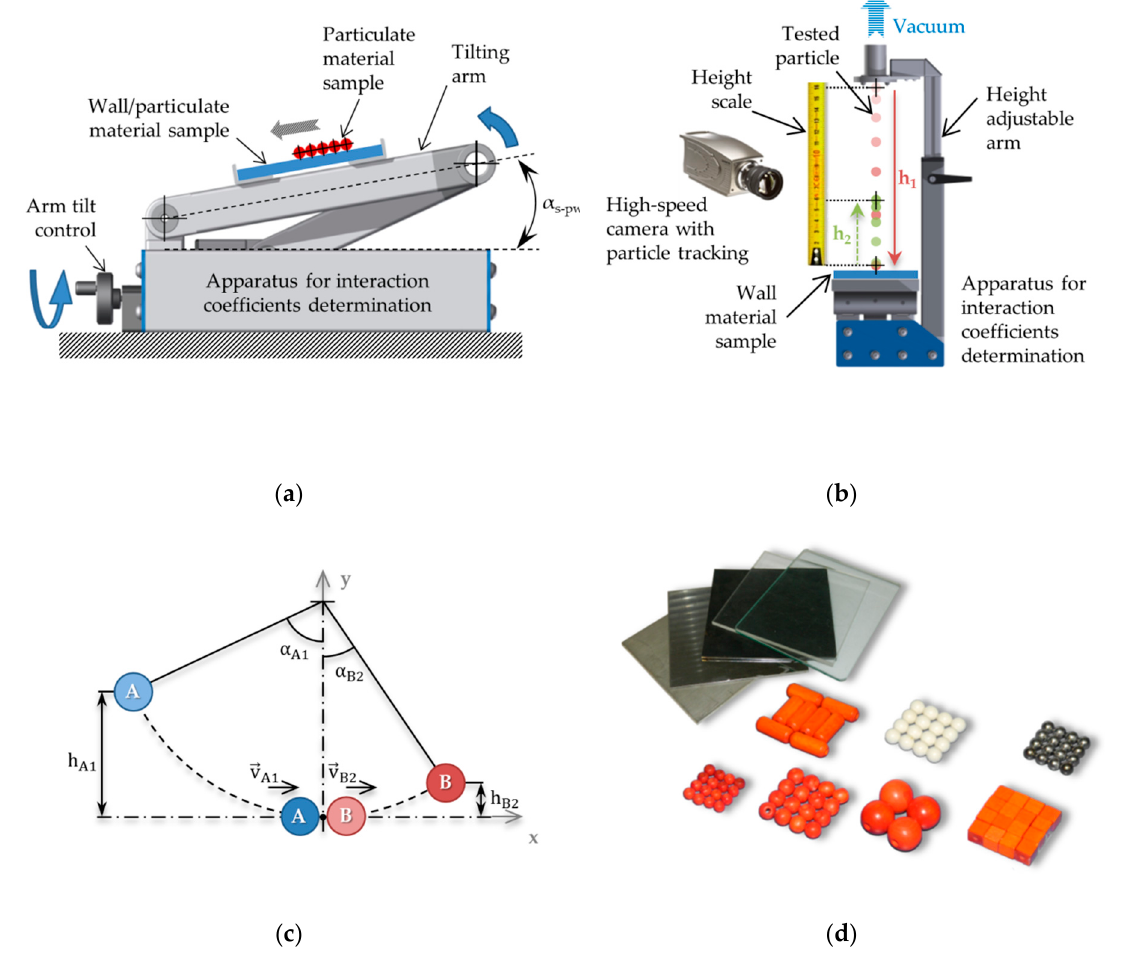
Figure 3. Interaction coefficient determination schemes: ( a ) static friction; ( b ) particle-wall coefficient of restitution (CoR); ( c ) particle-particle CoR; ( d ) wall and particle clump samples.